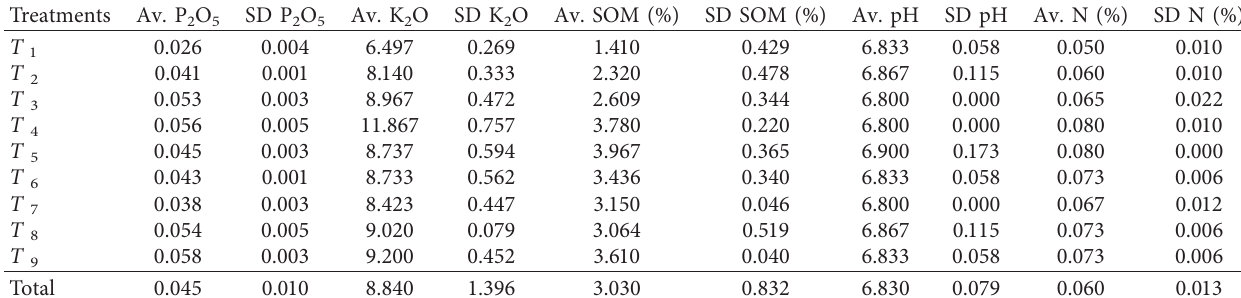
Table 3: Initial chemical properties of soil (0–15cm) at RARS, Khajura.